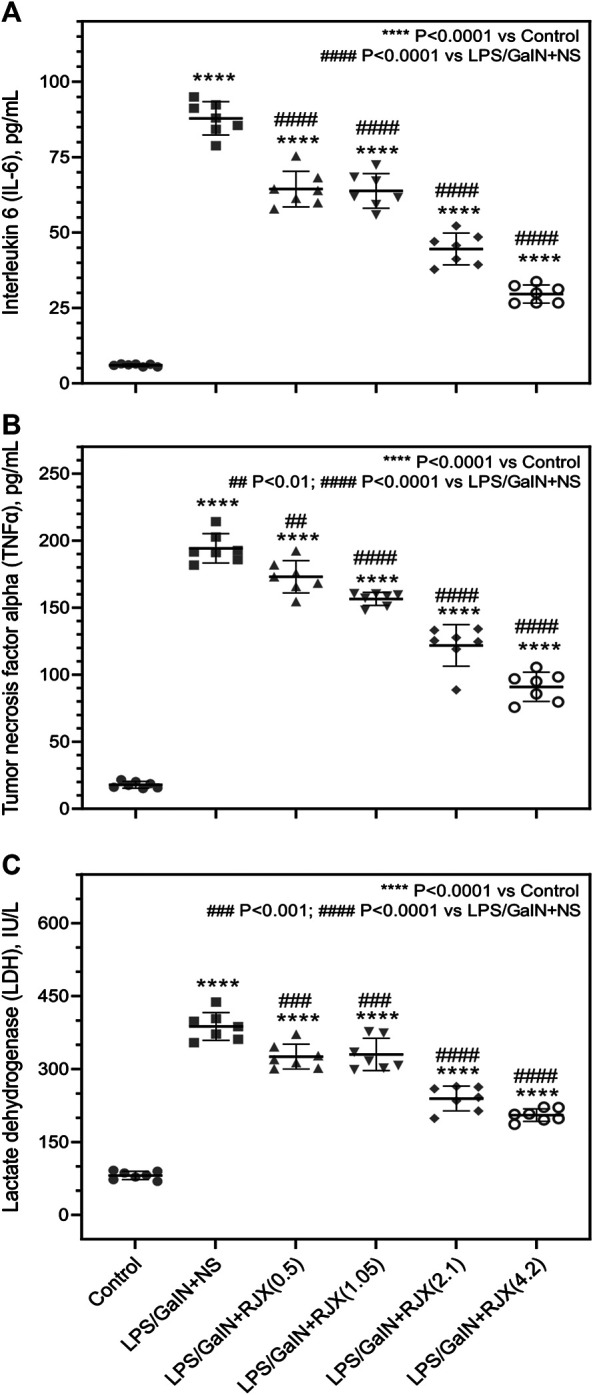
Rejuveinix (RJX) Prevents the Surge of Inflammatory Markers in the Blood Following Lipopolysaccharide-Galactosamine (LPS-GalN) Challenge in a Mouse Model of acute respiratory distress syndrome (ARDS) and Multi-organ Failure. Mice were treated with i.p injections of RJX (0.5, 1.05, 2.1, 4.2 ml/kg of 6‐fold diluted RJX, 0.5 ml/mouse) or normal saline (NS) 2 h before and 2 h post-injection of LPS-GalN. Except for untreated mice (Control), each mouse received 0.5 ml of LPS-GalN (consisting of 100 ng of LPS plus 8 mg of D-galactosamine) i.p. The RJX dose levels (in ml/kg) are indicated in parentheses. See text for discussion of results. The depicted lines represent the mean and standard deviation for the indicated inflammatory markers, namely serum IL‐6 (Panel A), TNF‐a (Panel B), and LDH levels (Panel C). ANOVA and Tukey’s post-hoc test were used for comparing the results among different treatment groups. Statistical significance between groups is shown by: ****p < 0.0001 compared as control group and, #p < 0.05; ##p < 0.01; ####p < 0.0001 compared as LPS/GaIN + NS group).